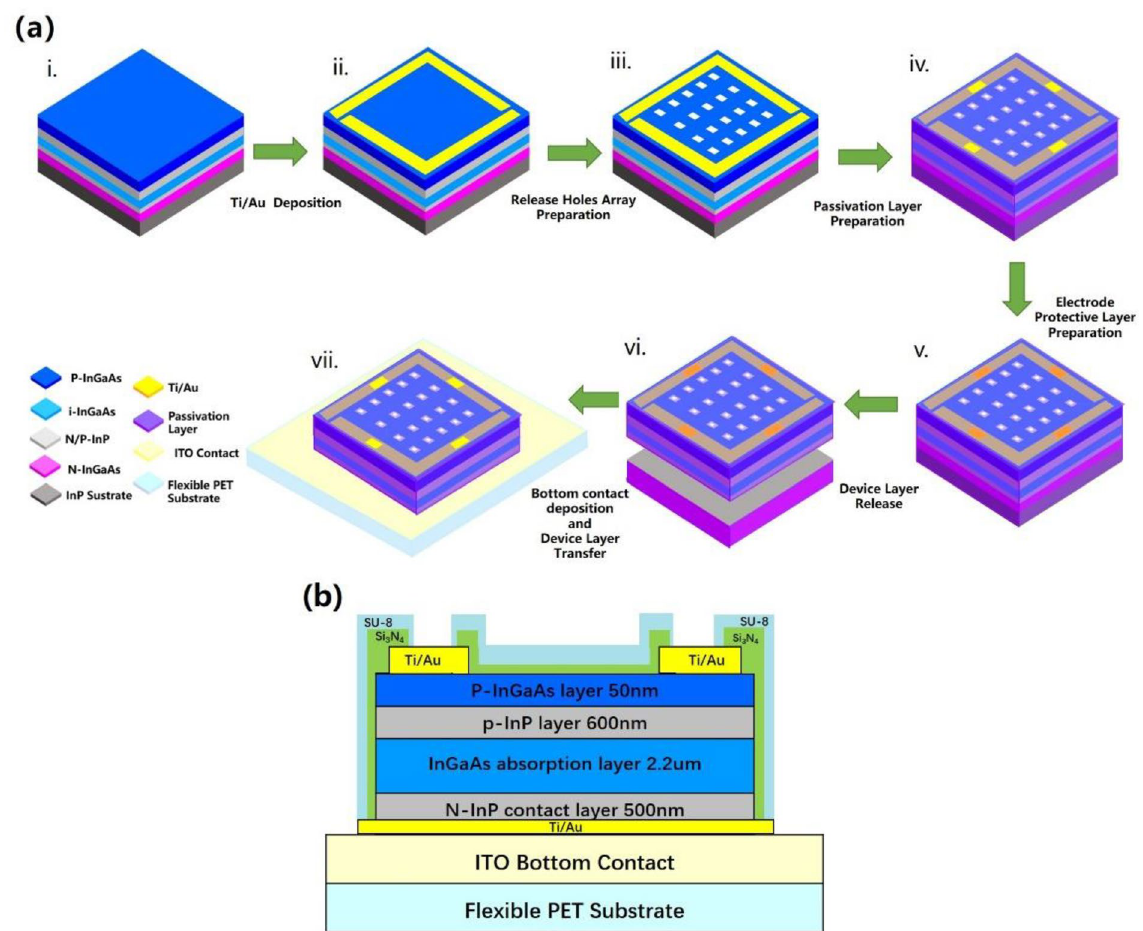
Figure 1. Device fabrication: ( a ) A flow chart for fabrication process: (i) Material growth of InGaAs PIN PD, (ii) Deposition of Up-contact metal frame. (iii) Preparation of release holes array, (iv) Preparation of passivation layer, (v) Preparation of electrode protective layer, (vi) Peeling off the InGaAs PIN membranes, (vii) Deposition of bottom contact and transfer of devices. ( b ) Cross-sectional structure of a fabricated InGaAs PIN flexible PD based on ITO-PET flexible